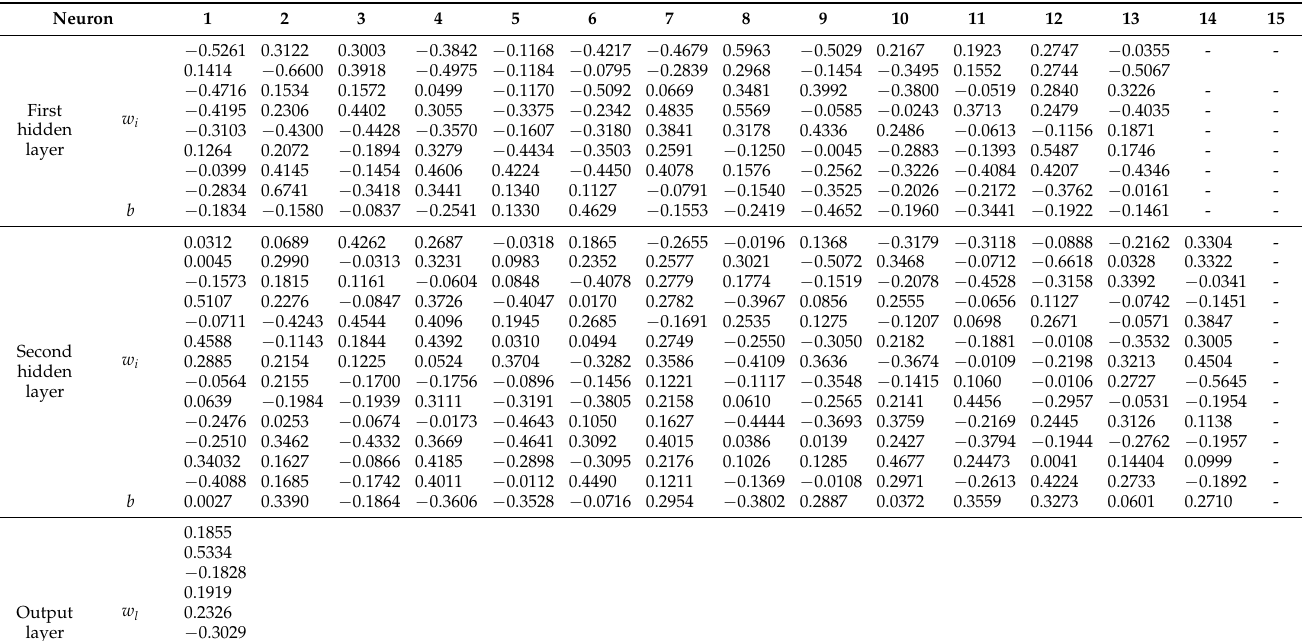
Table A1. Characteristic weights and biases of the DRI − ANN − MLP model with the best